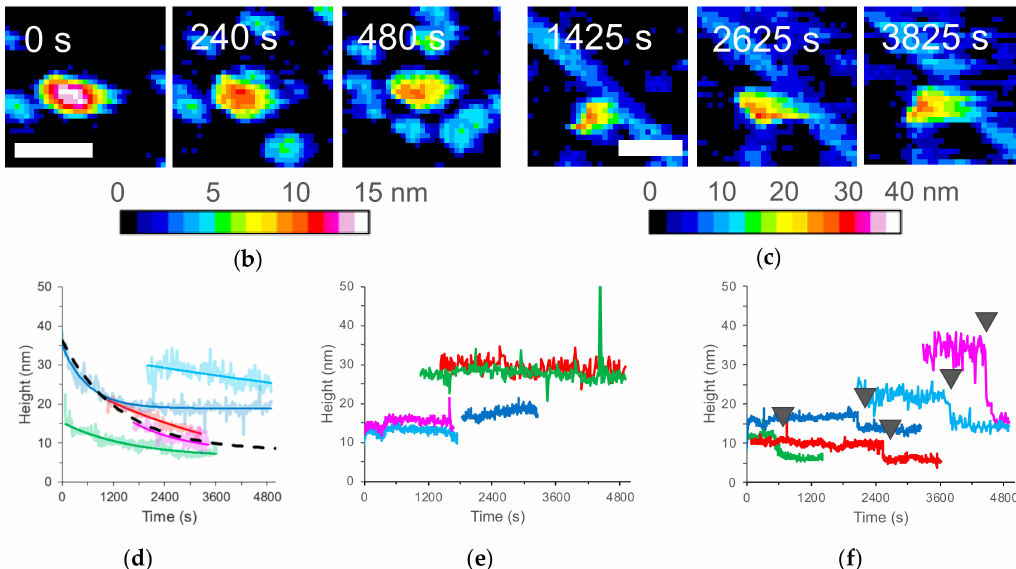
Figure 6. HS-AFM observation of non-fibrous aggregates in high molecular weight (HMW) A β 42 incubation. ( a ) HS-AFM images of HMW A β 42 incubation at the indicated time after the addition of 0.1 M NaCl. A closed triangle in the highlighted dashed box indicates a representative short fibril